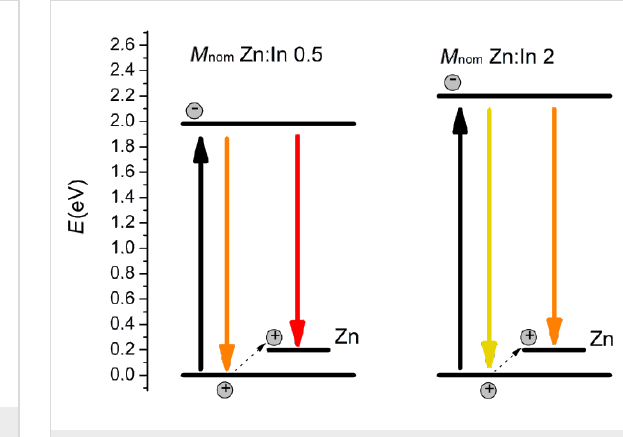
Figure 12: The scheme of PL formation with participation of Zn levels.